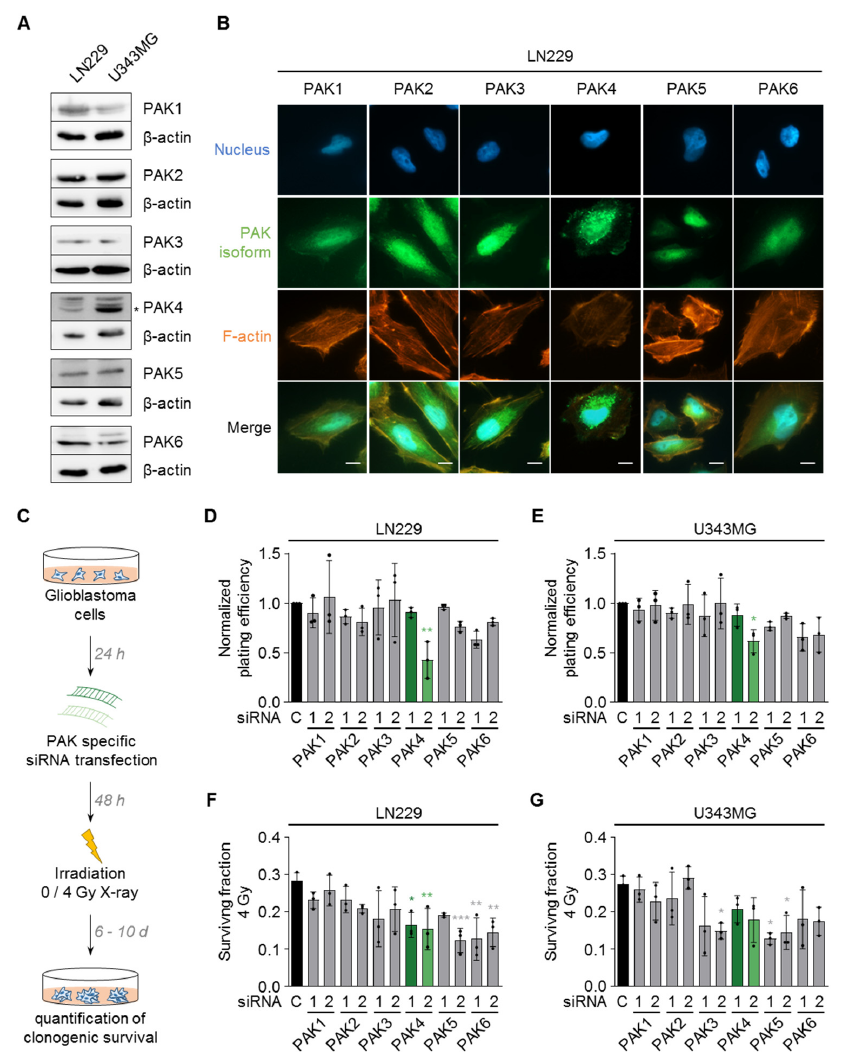
Figure 1. PAK isoforms differentially regulate glioblastoma cell radiosensitivity. ( A ) Representative Western blot images of the expression of the indicated PAK isoforms in LN229 and U343MG cell lines. β -actin served as loading control. ( B ) Representative immunofluorescence images of the nucleus (DAPI), the indicated PAK isoforms, and F-actin (Phalloidin) in LN229 cells. Scale bar: 5 µ m. ( C ) Workflow of the colony formation assay for the quantification of clonogenic survival. ( D , E ) Normalized plating efficiency (basal clonogenic survival) of ( D ) LN229 and ( E ) U343MG cells upon knockdown of the different PAK isoforms. ( F , G ) Surviving fraction of ( F ) LN229 and ( G ) U343MG cells upon knockdown of the different PAK isoforms with and without 4 Gy X-ray irradiation. ( D – G ) Data show means +/– SDs (N = 3 independent experiments, one-way ANOVA, Dunnett’s post-hoc test, * p < 0.05, ** p < 0.01, *** p <